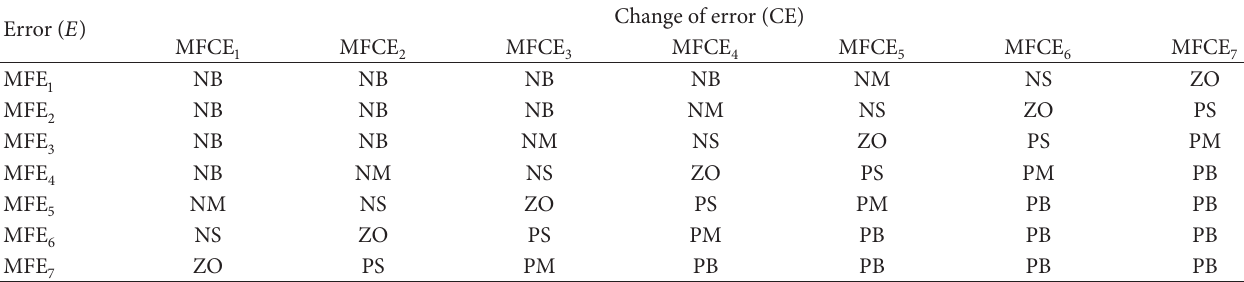
Table 1: Fuzzy control rules based on seven